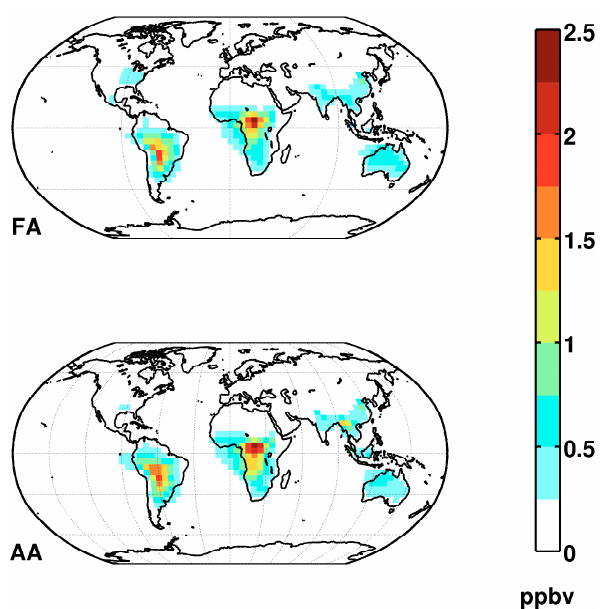
Fig. 1. Annual simulated distribution of FA and AA in the boundary layer. FA and AA maxima in the tropics reflect strong biogenic